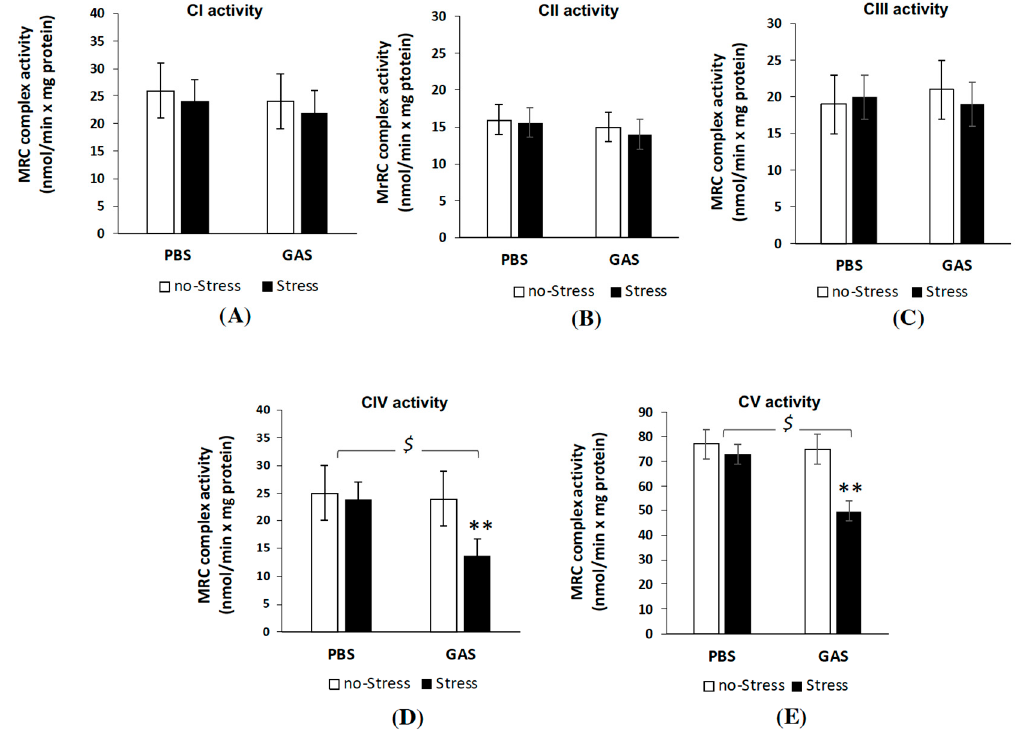
Figure 6. Mitochondrial respiratory chain (MRC) complex activities in brain of GAS-Stress mice and relative controls. The activities of the MRC ( A ) complex I, ( B ) complex II, ( C ) complex III, ( D ) complex IV and ( E ) complex V (ATP synthase) were measured spectrophotometrically in mitochondrial membrane enriched fractions from cryopreserved brain hemispheres of wt littermates control mice (PBS-no Stress), Group-A beta-haemolytic streptococcus exposed mice (GAS-no Stress), psychosocially stressed mice (PBS-Stress) and psychosocially stressed mice exposed to haemolytic streptococcus (GAS-Stress), at two weeks from treatment endings. Complex activities are expressed as nmol / min × mg protein. Data are mean rates ± SD obtained from three independent experiments. For MRC complex IV and V activities $ p < 0.05 for PBS-Stress vs. GAS-Stress; ** p < 0.01 for GAS no-Stress vs. GAS-Stress. Cohen’s d measures are reported in Table